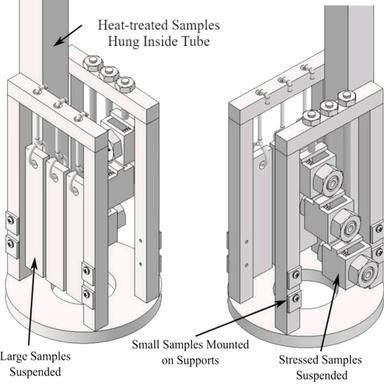
CAD of the sample stand highlighting how each sample type is mounted inside the canister. Left is for large samples and Right is for bolts which much maintain integrity even under stress.